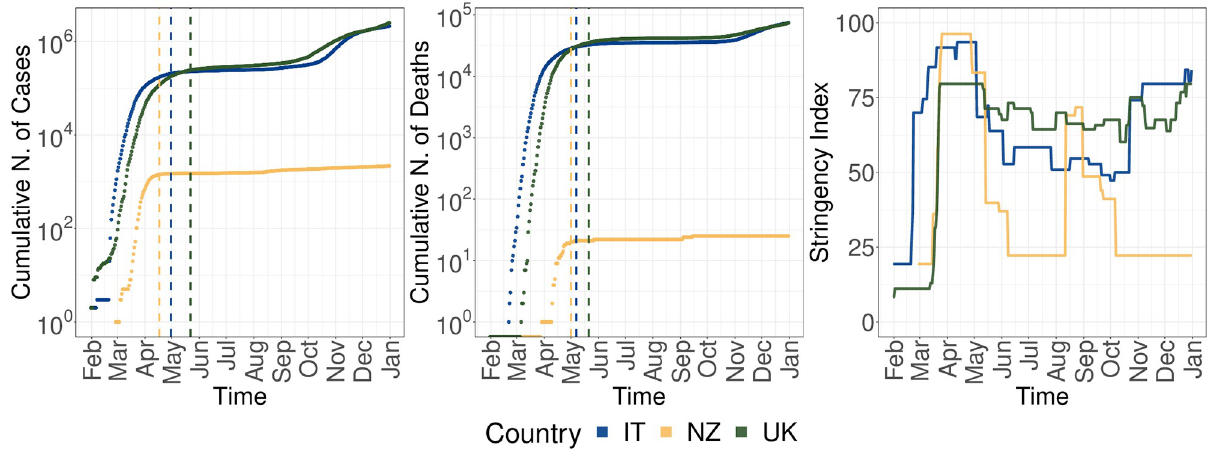
Fig 1. Overview of COVID-19 outbreak in 2020 depicted by: the cumulative number of confirmed cases (left) and deaths (middle), and the evolution of the Stringency Index (right) for Italy (IT—represented in blue), New Zealand (NZ—represented in yellow) and United Kingdom (UK—represented in green). Dashed lines represent the first plateau of the corresponding metric for each country, with a change ratio below than 1%.